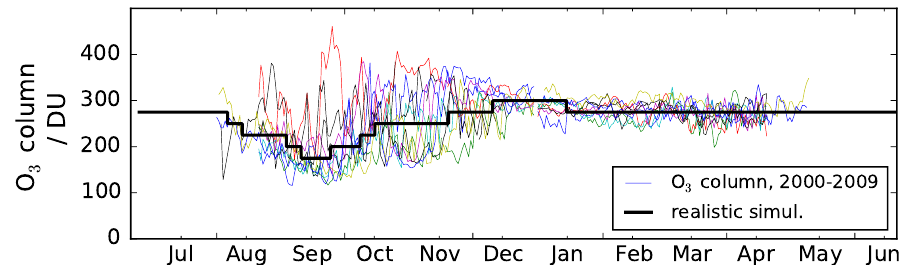
Figure 3. Driving ozone column data for the DC realistic simulation versus observed annual time series for years over the 2000–2009.